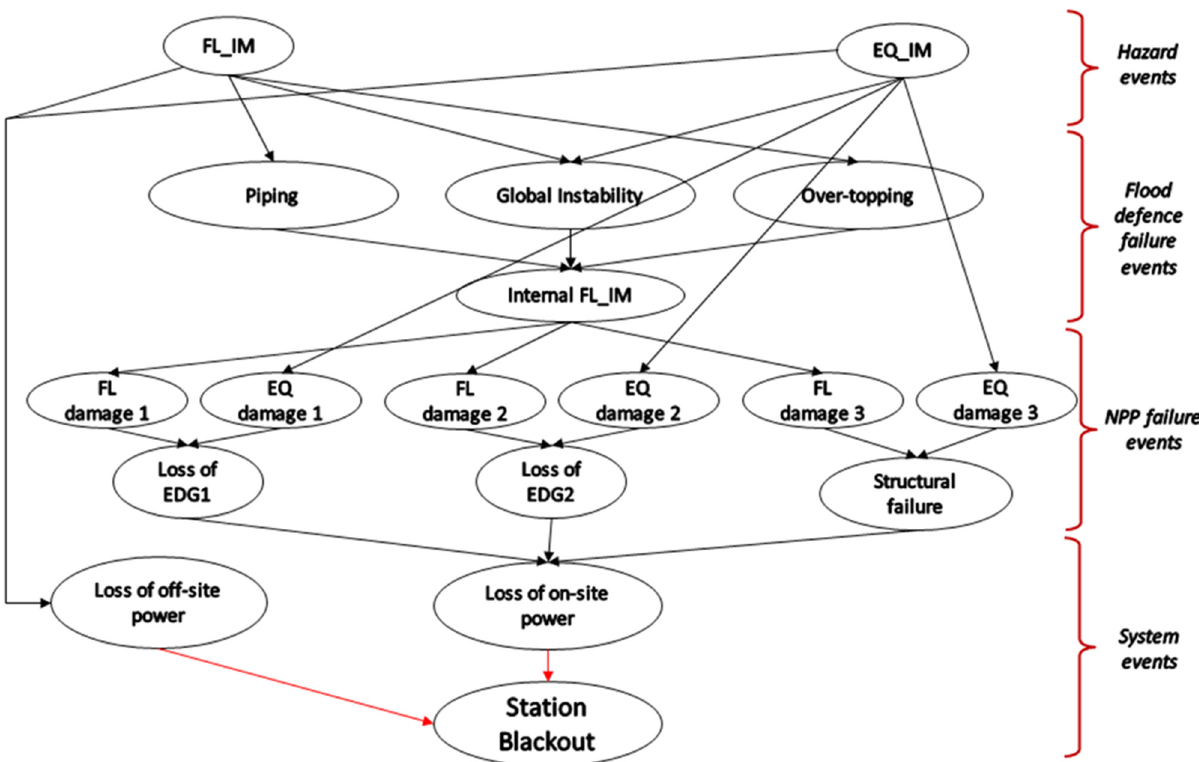
Fig. 5. Illustration of a very simpli fi ed BN construction considering combined hazard events (e.g. fl ooding & earthquake): each node corresponds to a full probability